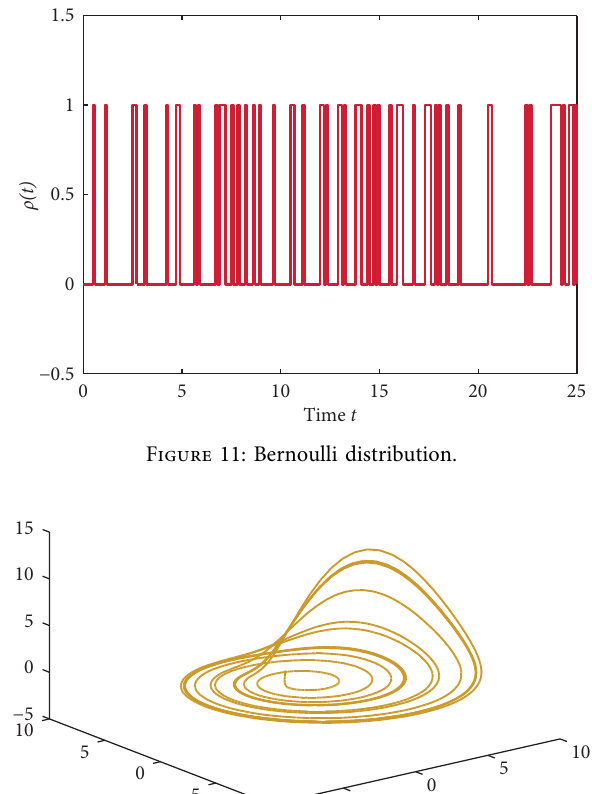
Figure 12: Chaotic attractor of the Rossler